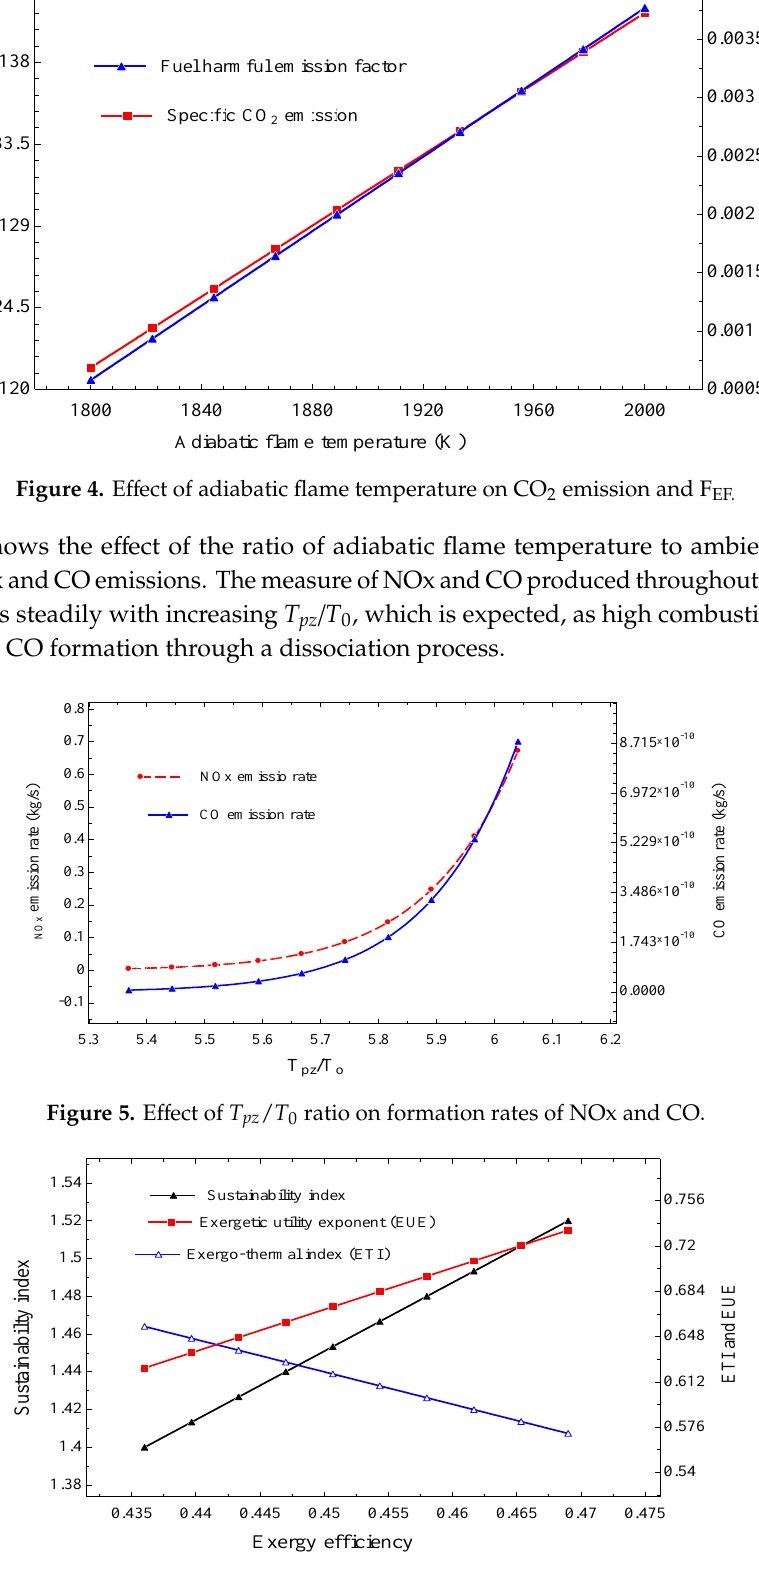
Figure 6. Change in exergy efficiency on sustainability indicators.